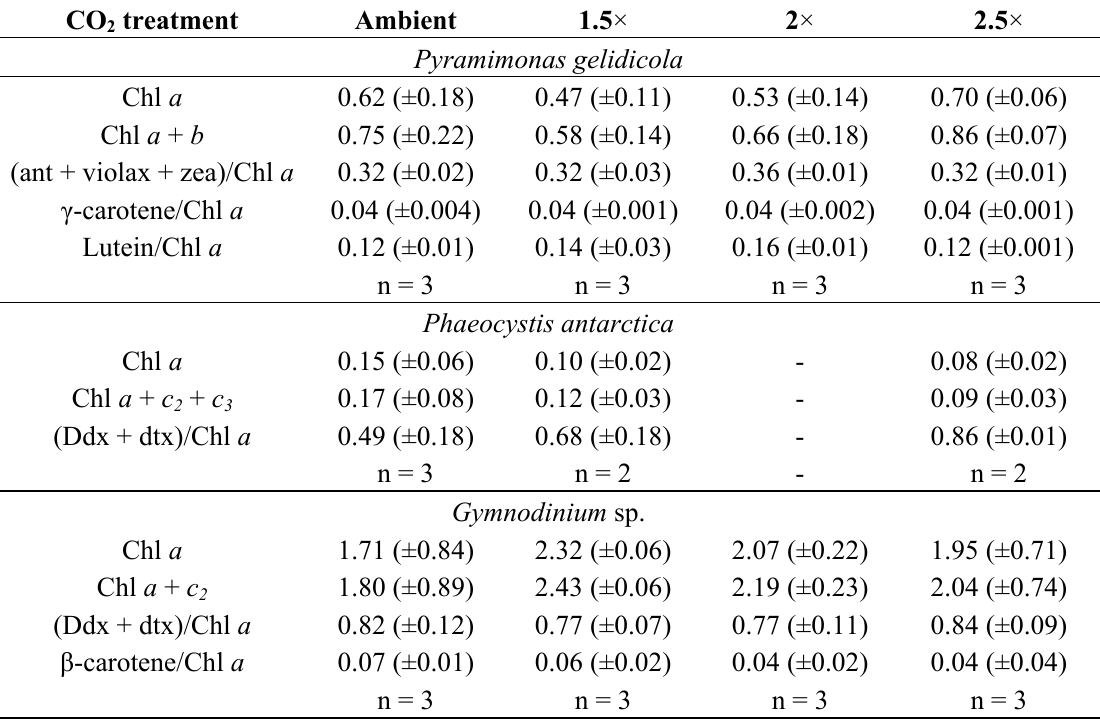
Table 3. Phytoplankton pigment ratios and contents in pg cell − 1 of the respective CO